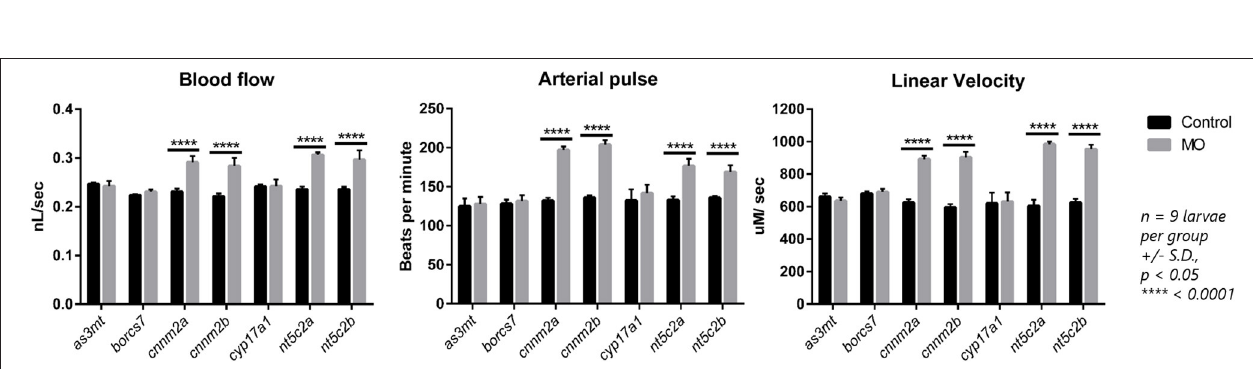
FIGURE 4 | Graphs represents blood flow parameters measured after downregulation of as3mt, borcs7, cnnm2a, cnnm2b, cyp17a1, nt5c2a, and nt5c2b genes in zebrafish using transcriptional splice modification morpholinos. Blood flow (nL/sec), arterial pulse (beats per minute) and linear velocity ( µ M/sec) compared against their respective control groups. Data was generated from n = 9 larvae per groups, error bars represents standard deviation and significance was set at p < 0.05.